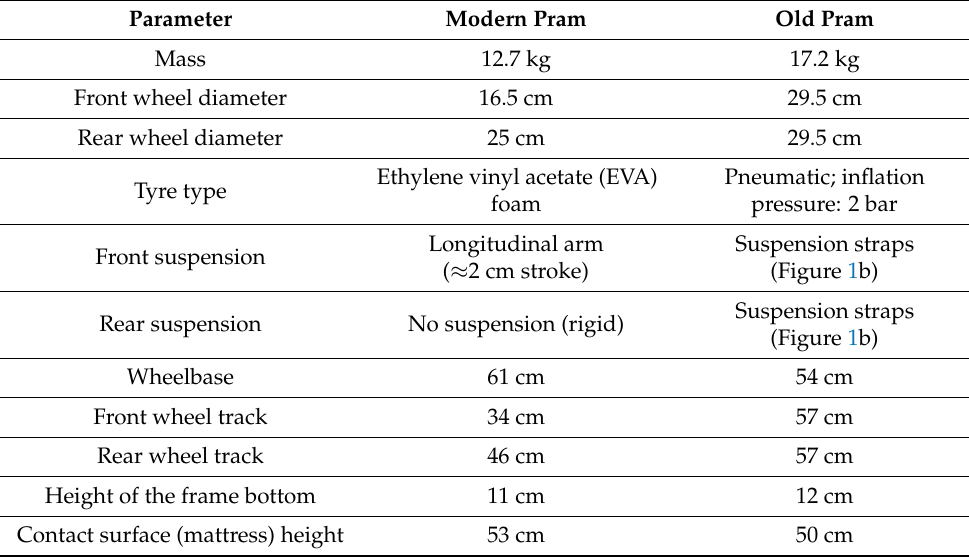
Figure 1. Photograph of the tested perambulators: ( a ) —a lightweight modern “3 in 1” pram (here- inafter the modern pram), ( b ) —an “old type” heavy pram with pneumatic tyres (hereinafter the old pram). Table 1. Comparison of the tested perambulators’ design parameters .